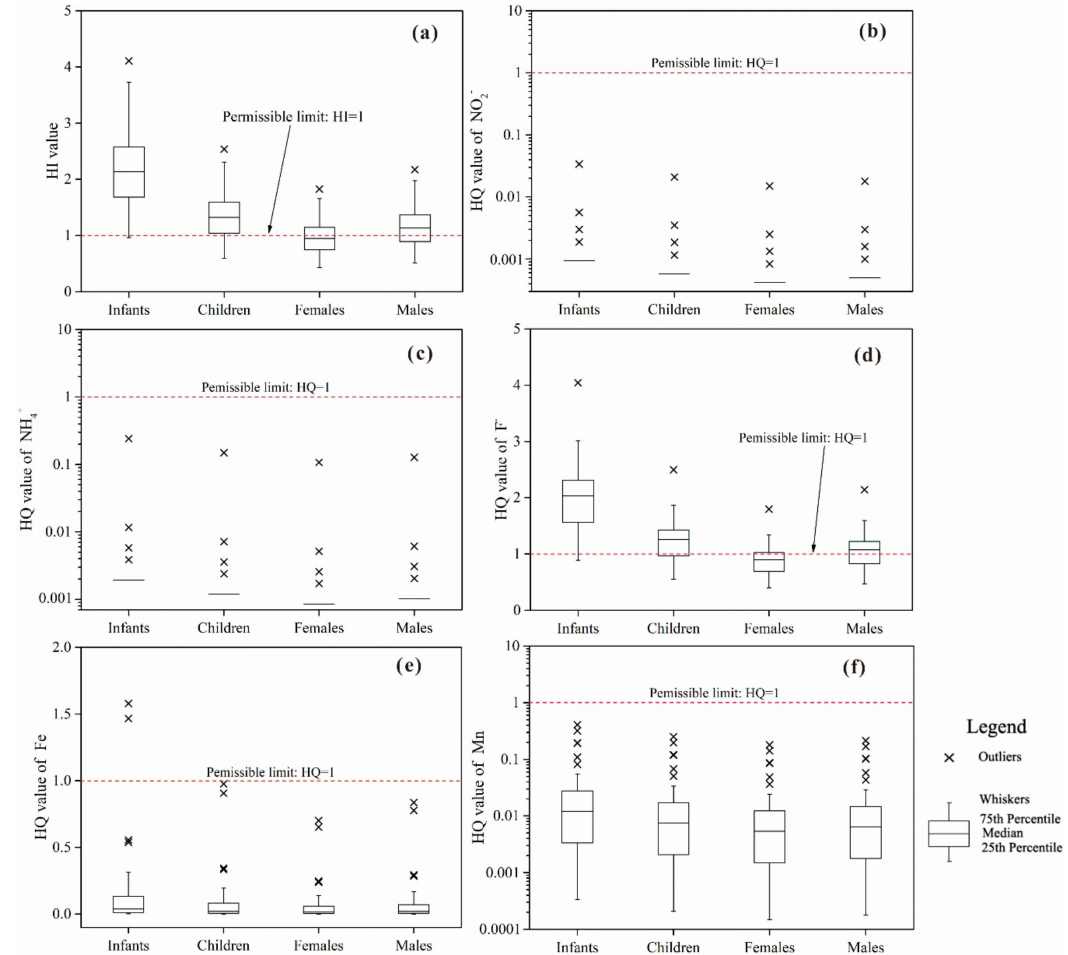
Figure 9. Box plots of ( a ) the overall non-carcinogenic health risk, and the hazard quotient of non-carcinogenic health risk due to ( b ) NO 2 − , ( c ) NH 4 + , ( d ) F − , ( e ) Fe, and ( f )